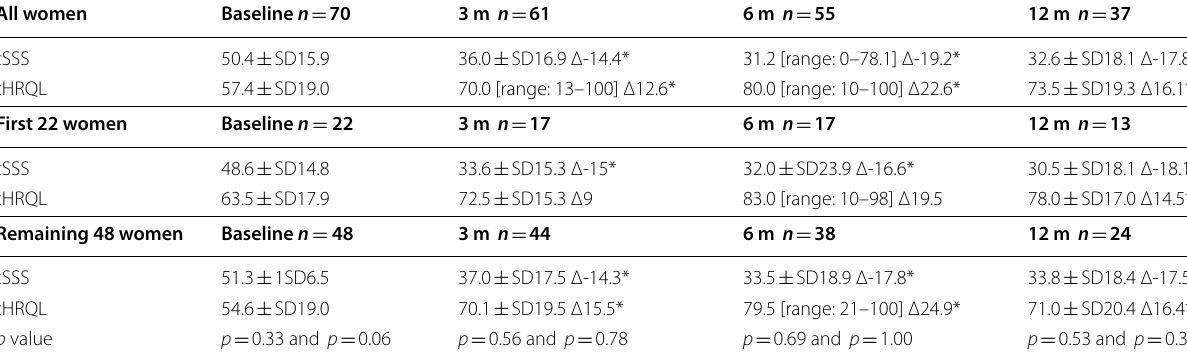
Showing all women and divided in the first 22 and second 48 women treated. Δ shows the absolute difference with baseline, and *shows a significant difference ( p < 0.05) compared to baseline. The bottom row of the table shows p values of the difference between the first 22 and second 48 women treated for tSSS or tHRQL = at that particular time point, tested by Mann–Whitney U test. Multiple testing correction was performed using the Holm–Bonferroni method